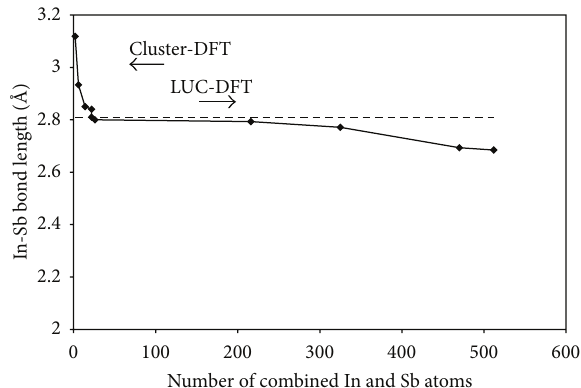
Figure 7: In–Sb bond length as a function of number of atoms for InSb molecules and nanocrystals. The dashed line represents the experimental bulk value of bond length [9].